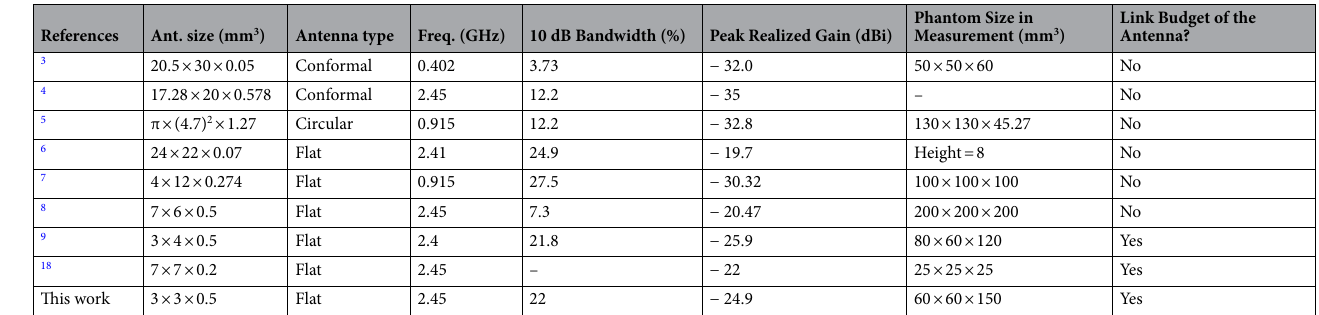
Table 4. Comparison of the proposed antenna to the same type of the antenna